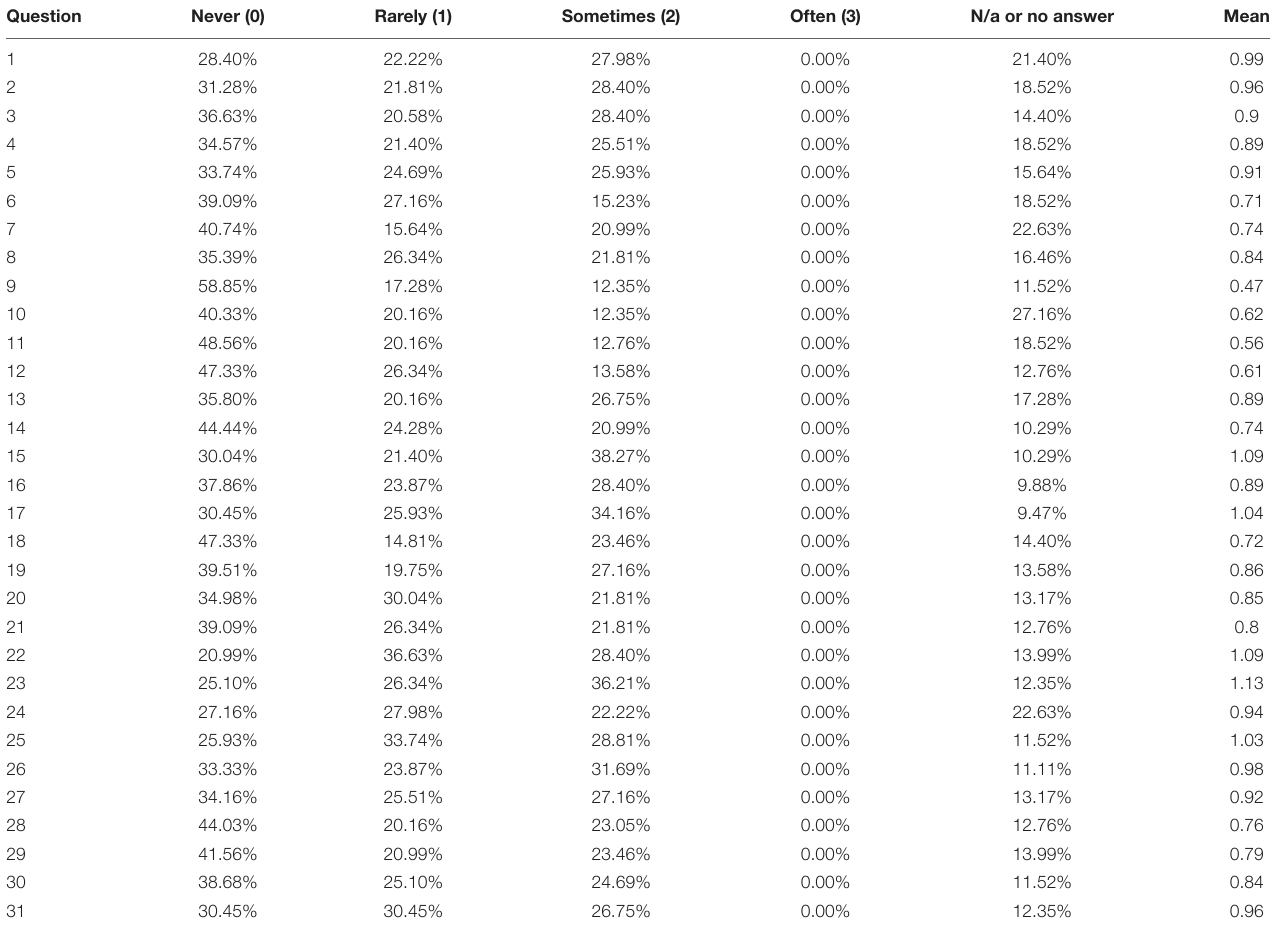
TABLE 5 | Distribution of answers of the Perceived Implicit Rationing of Nursing Care (PIRNCA)